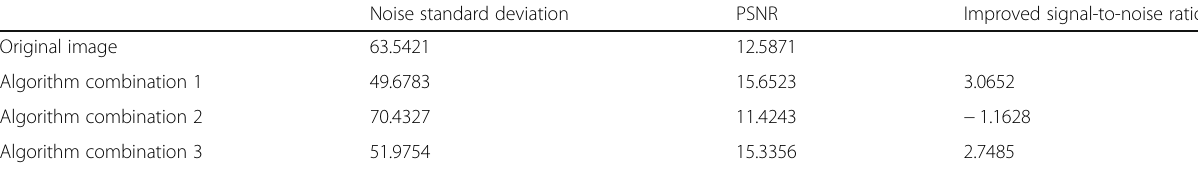
Table 1 Noise standard deviation of various combined algorithms and improvement of signal-to-noise